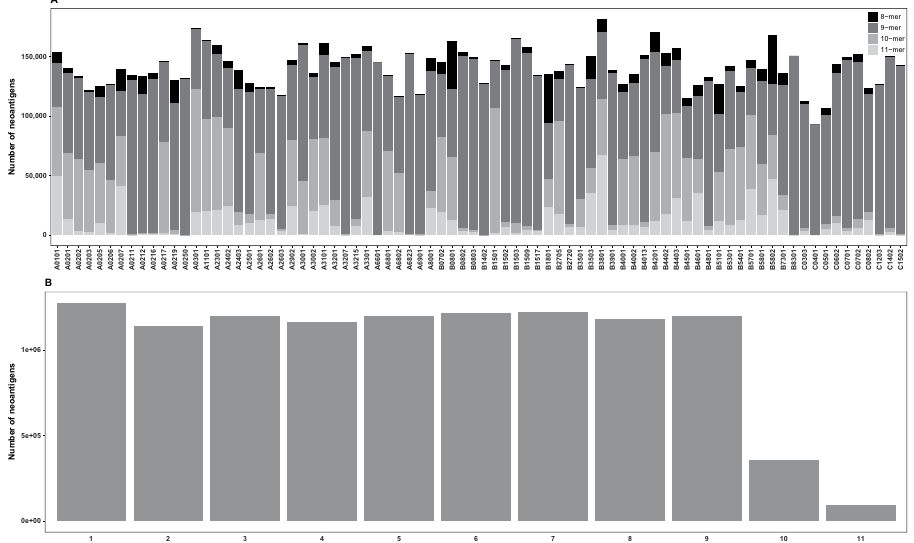
Figure 4. The distribution of neoepitopes among HLAs and to AAS at positions 1–11 in neoepitopes. ( A ) The distribution of neoepitopes among HLAs. The differences in the overall numbers of neoepitopes per HLA were minor. 9-mers are most common. ( B ) The distribution of AASs at positions 1–11 of the neoepitopes. The split down to the positions of variants within the peptides indicated very even distribution except for the small ratios for positions 10 and 11.